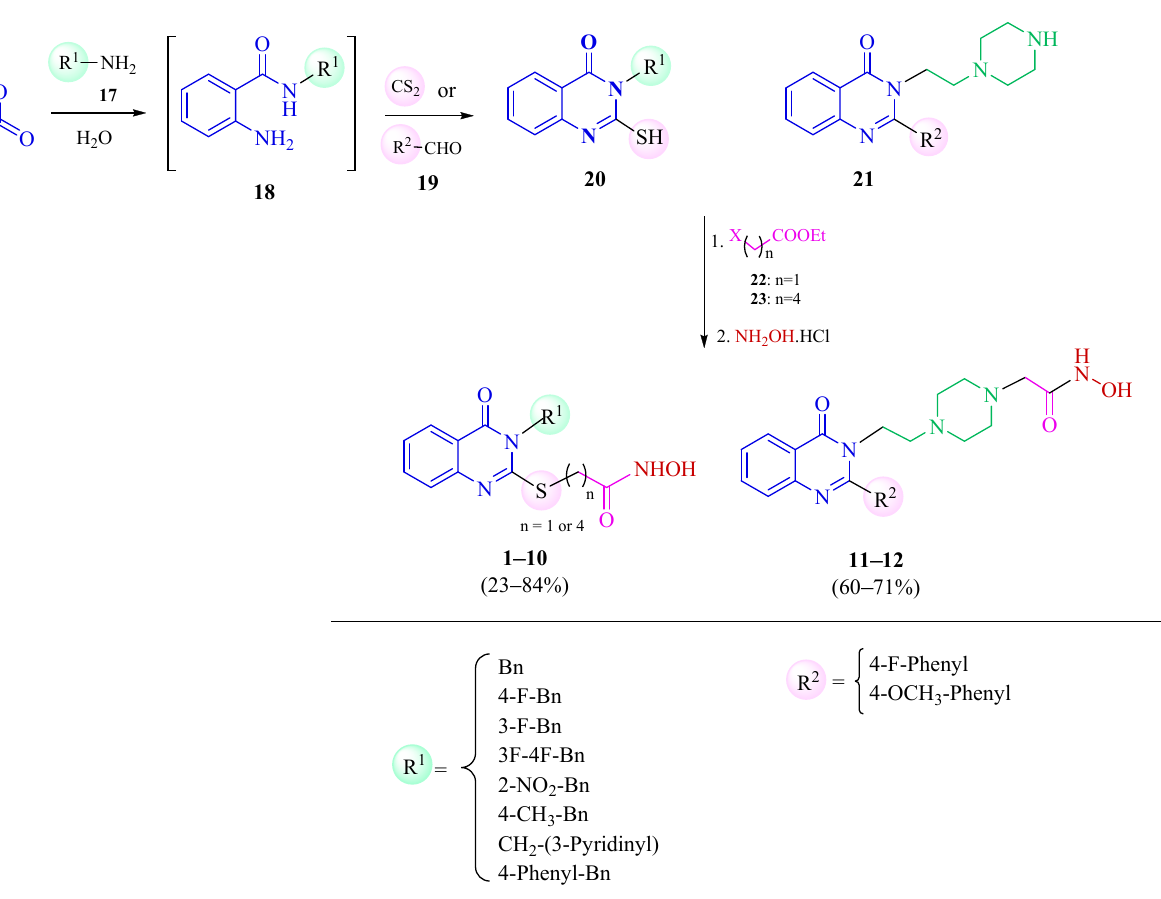
Table 1. Synthesis and antiproliferative activities of hydroxamate derivatives ( 1–15 ) against MCF-7 cell